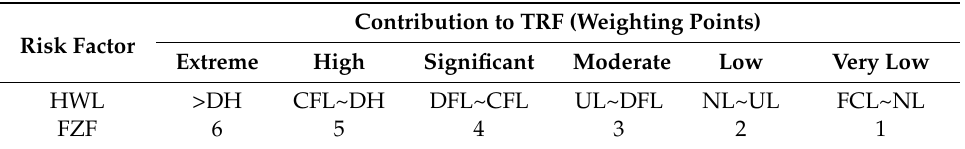
Table 4. Definitions of the highest water level (HWL) and the flood zoning factor (FZF). Contribution to TRF (Weighting Points) Risk Factor Extreme High Significant Moderate Low Very Low HWL